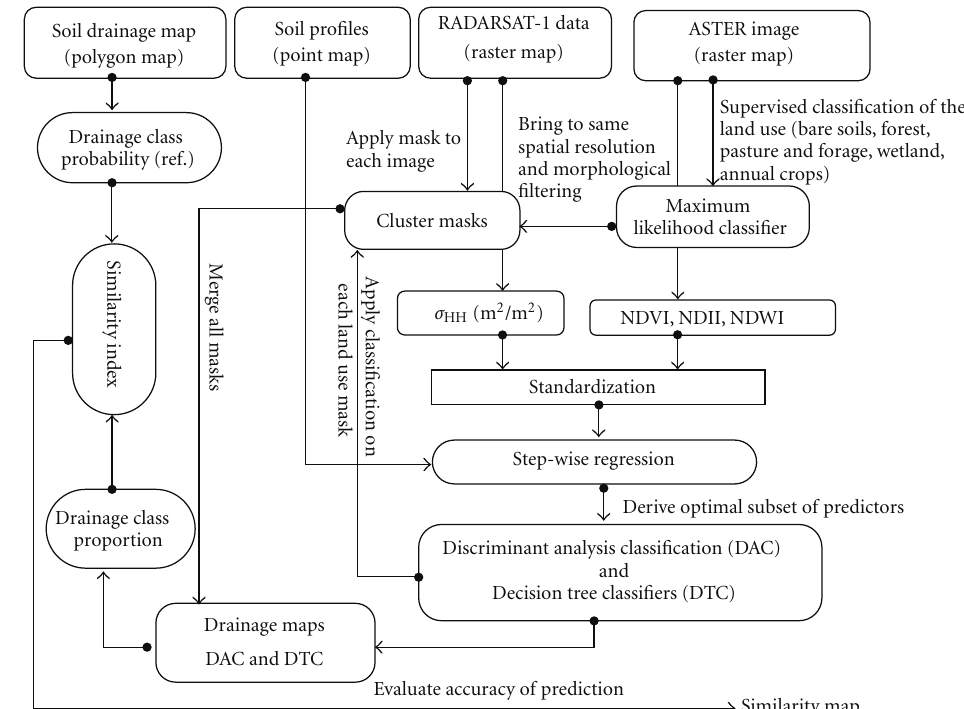
Figure 4: Framework used for soil drainage